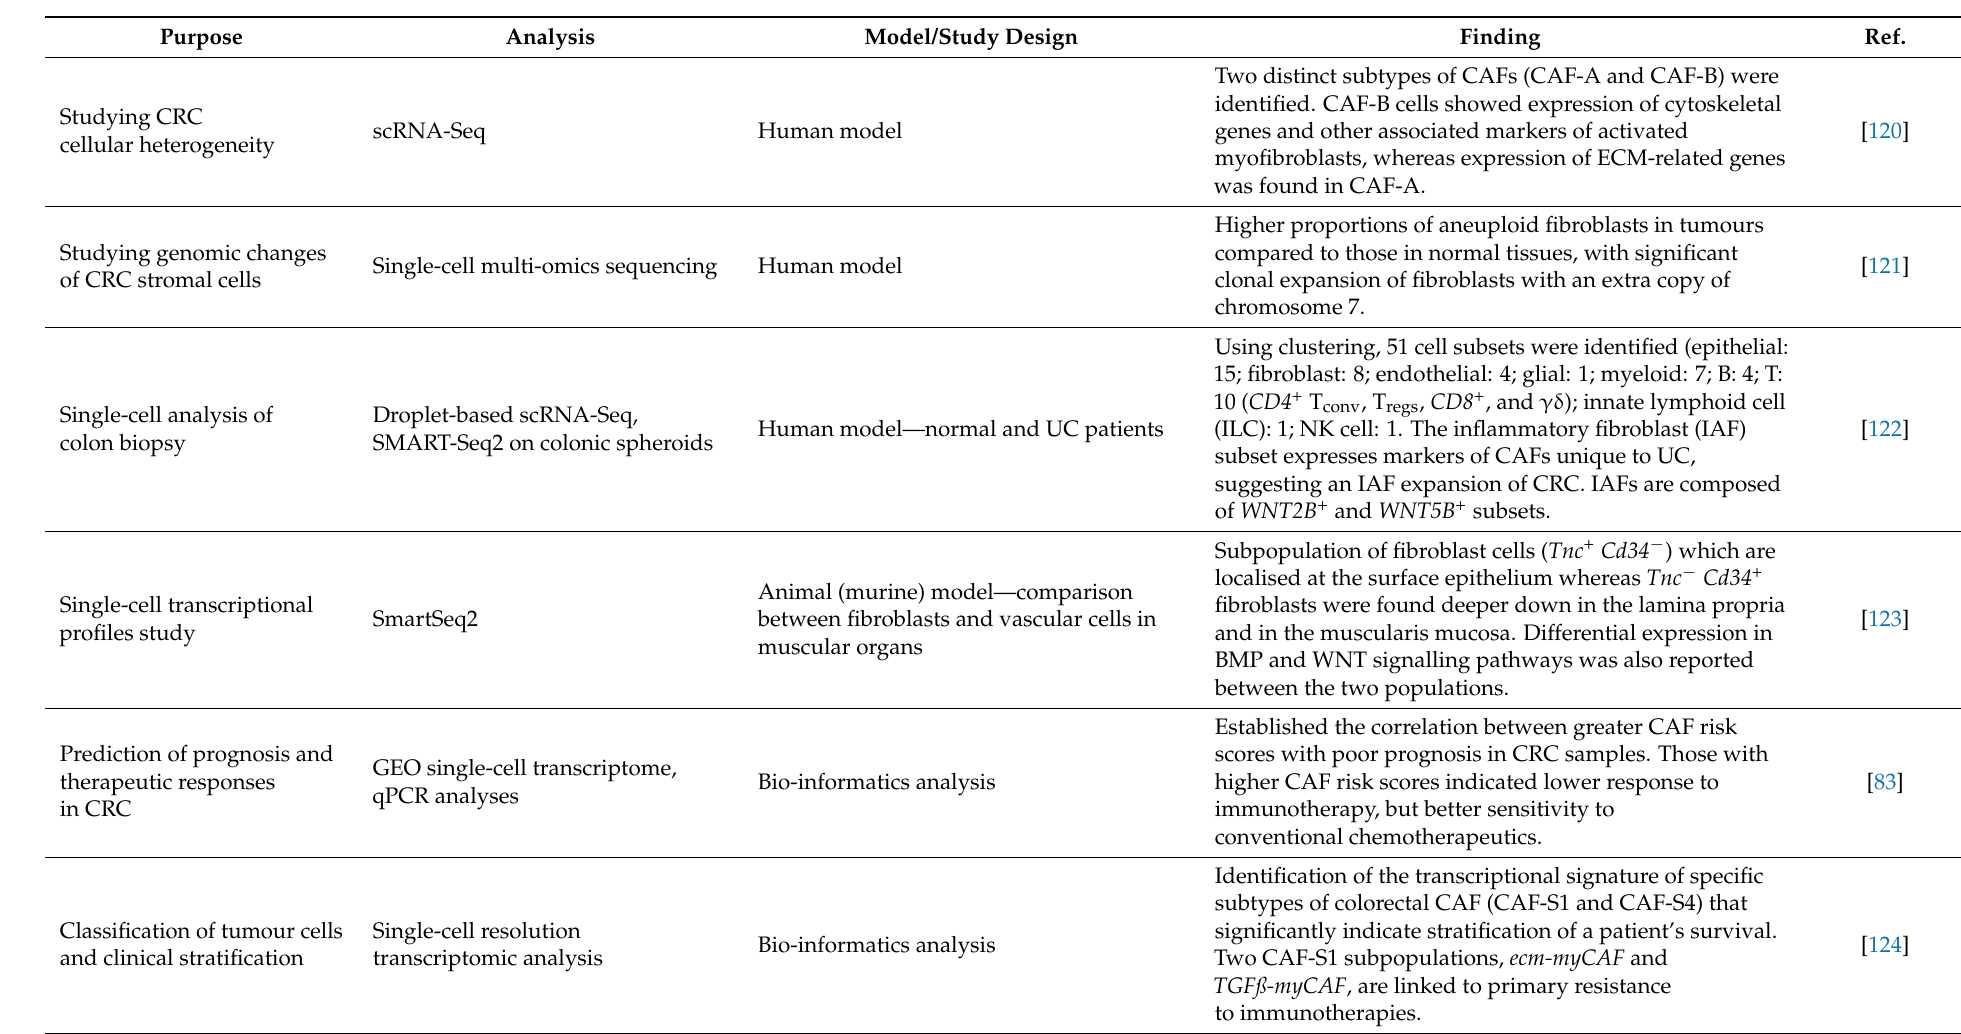
Table 2. Single-cell analysis on fibroblastic cells of